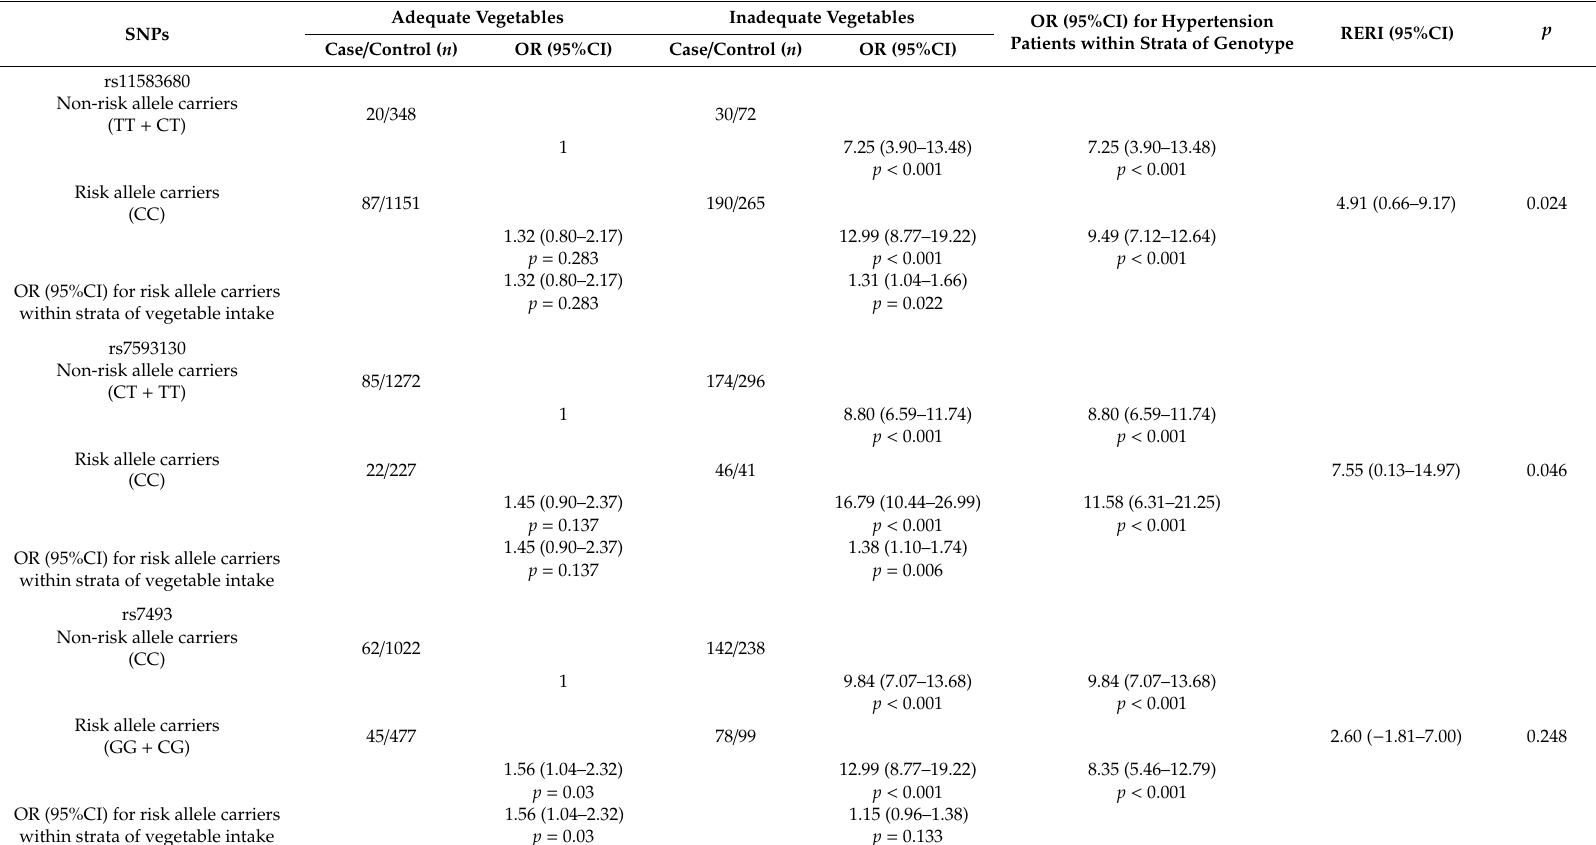
Table 4. Interactions between gene polymorphism and the intake of vegetables for the risk of